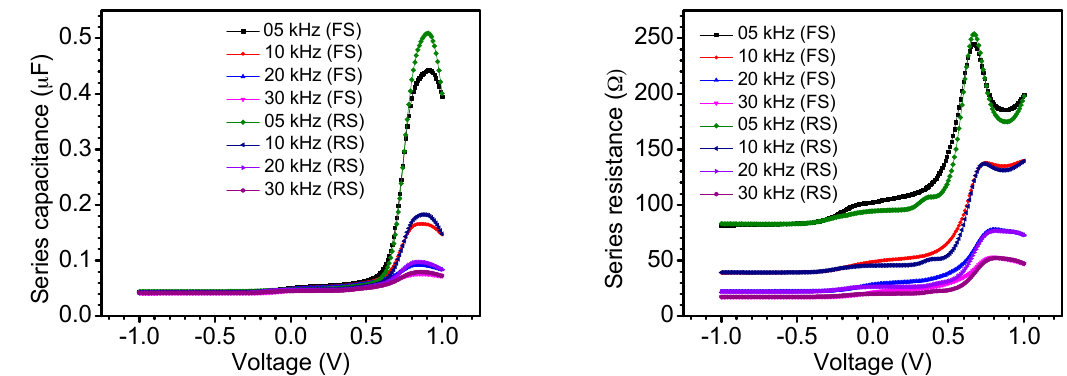
Figure 4. Series capacitance–voltage ( C S –V ) and series resistance–voltage ( R S –V ) curves recorded on the device in the dark at forward scan (FS: scan direction from − 1 to 1 V) and reverse scan (RS: scan direction from 1 to − 1 V) at different frequencies and a time delay of 0.2 s.